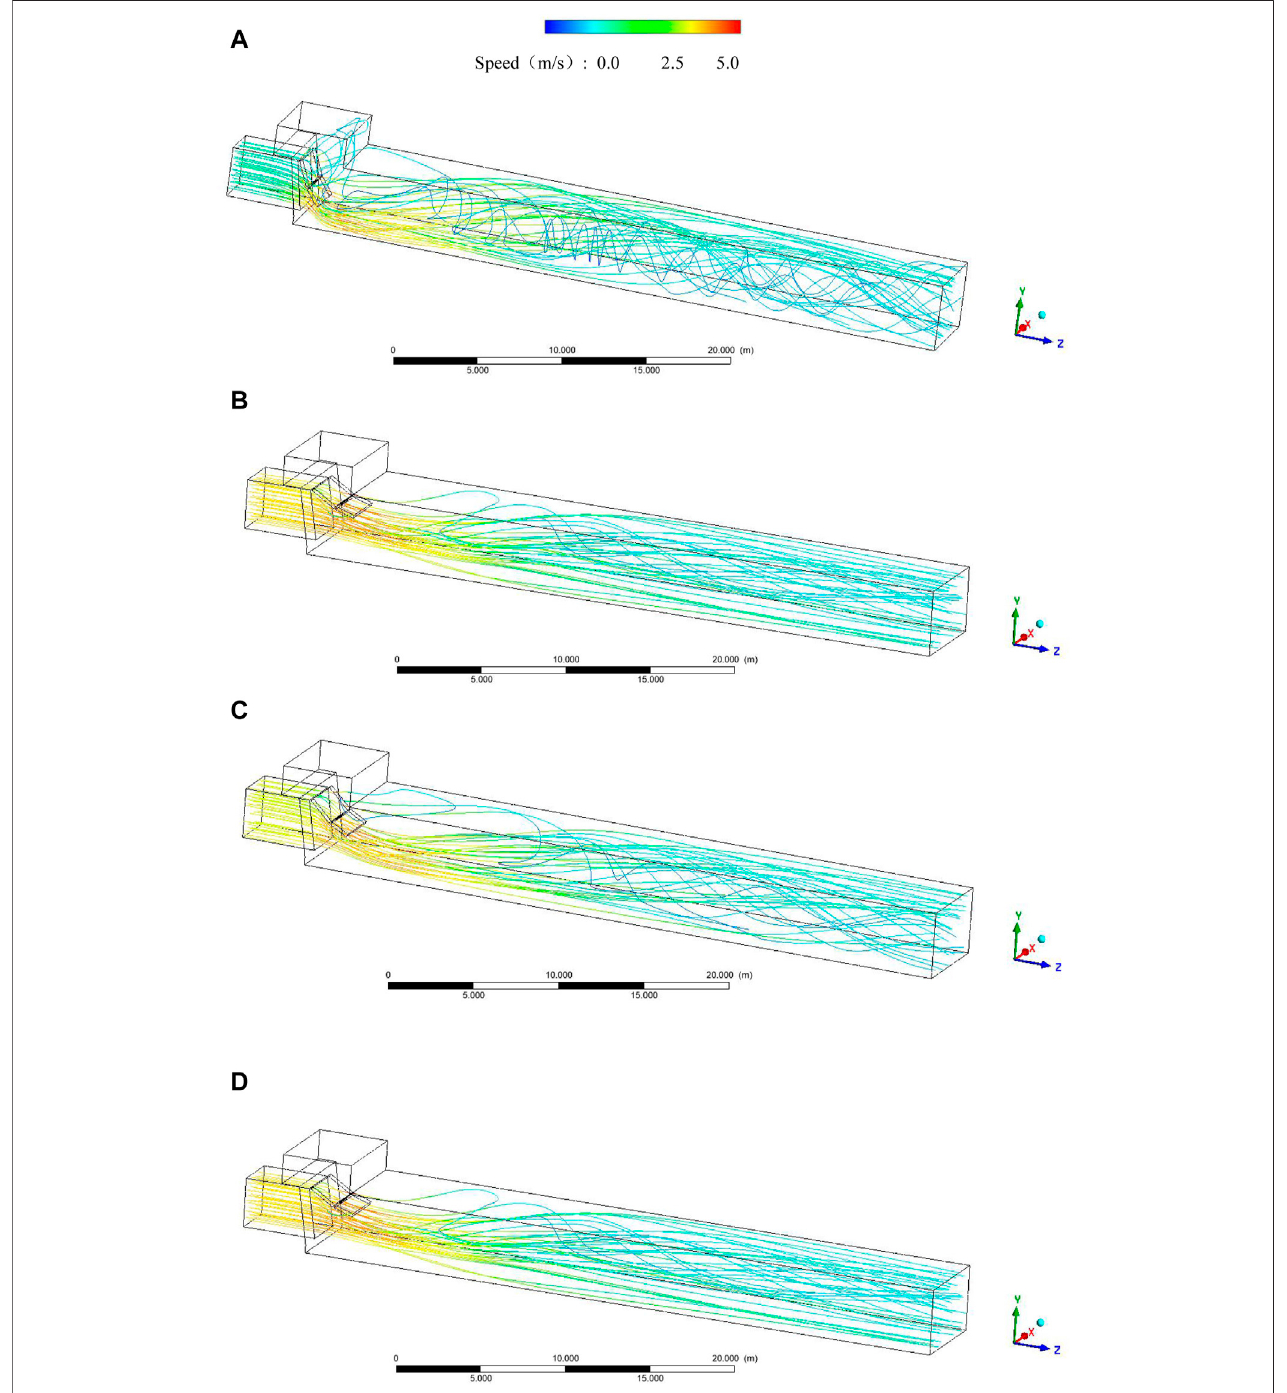
FIGURE 6 | Distribution of streamlines: (A) case 1, (B) case 2, (C) case 3, and (D) case 4.